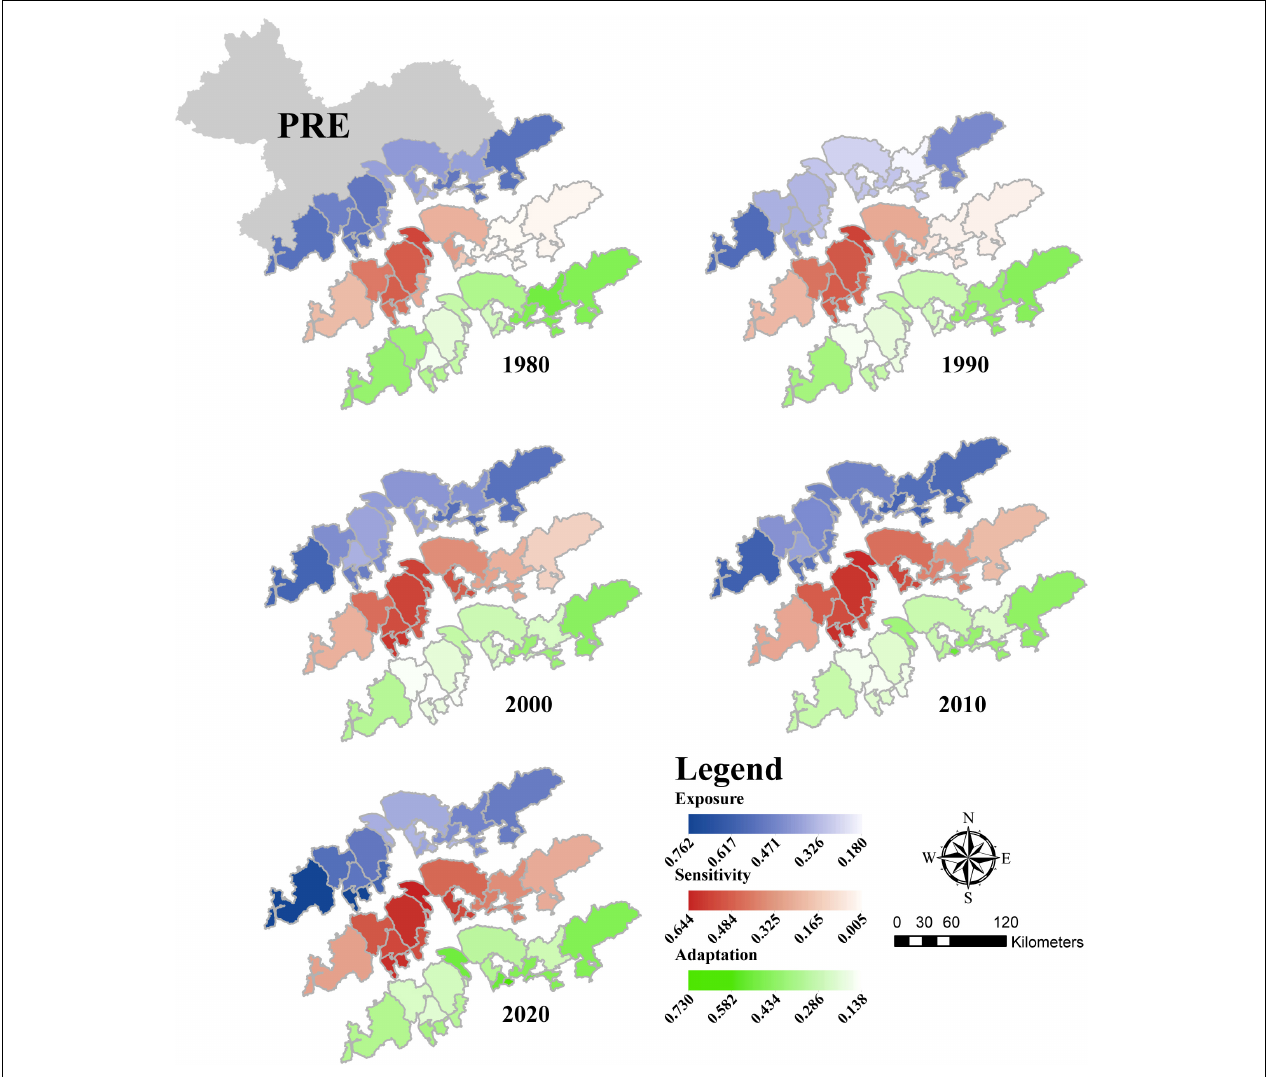
FIGURE 4 | Differences in exposure, sensitivity and adaptation in the coastal zone systems in 15 counties and districts in the study area. The depth and gradient of the three colors in the plots show the differences in ESA values in each county and